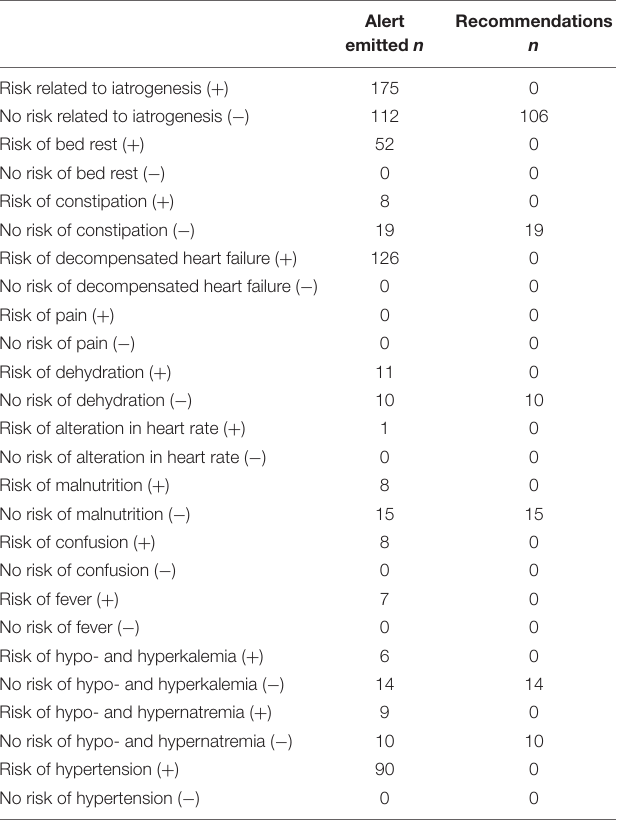
TABLE 3 | Alerts and recommendations issued for the other geriatric risks studied in the 10 diabetic elderly COVID